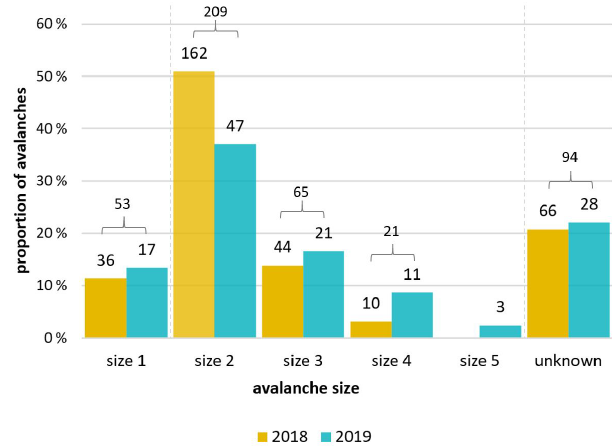
Figure 7. Number and proportion of avalanches per size for 2018 (left bar) and 2019 (right bar). The proportions are indicated relative to the number of avalanches per year (2018 – 318, 2019 – 127). For the avalanches of unknown size, the raters could not reliably determine the size (Sect. 3.2).